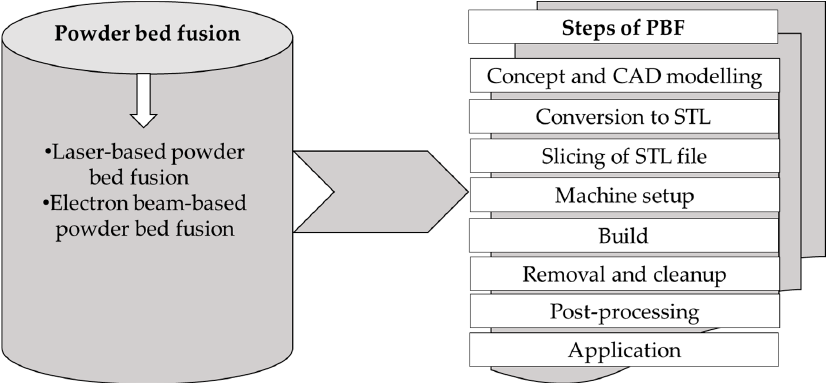
Figure 1. Schematic representation of powder bed fusion (PBF) systems and steps of manufacturing